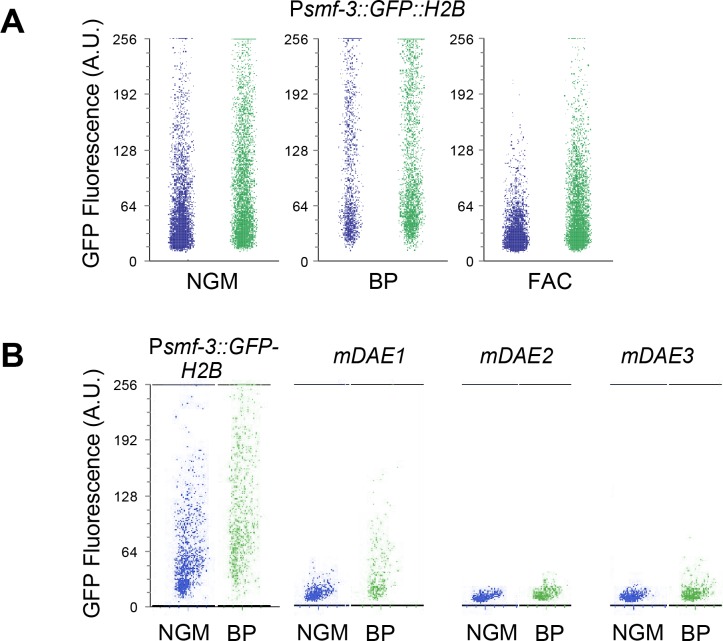
COPAS Biosort data for Psmf-3::GFP-H2B transgene expression.(A) GFP expression of Psmf-3::GFP-H2B worms fed control (empty vector) RNAi or nhr-14 RNAi and grown on NGM or NGM-BP (low iron) plates. (B) GFP expression of Psmf-3::GFP-H2B worms harboring a nucleotide mutation (G > C) in each DAE grown on NGM or NGM-25 µM BP plates. Worms were analyzed using COPAS Biosort where L4 stage to young adult worms were gated based on extinction and time of flight parameters (TOF). Extinction and TOF parameters were held constant for subsequent GFP fluorescence acquisition throughout all conditions. GFP fluorescence for 1000 worms was analyzed using FlowJo.